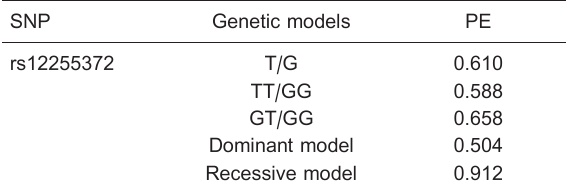
Table 3. Results of the Egger